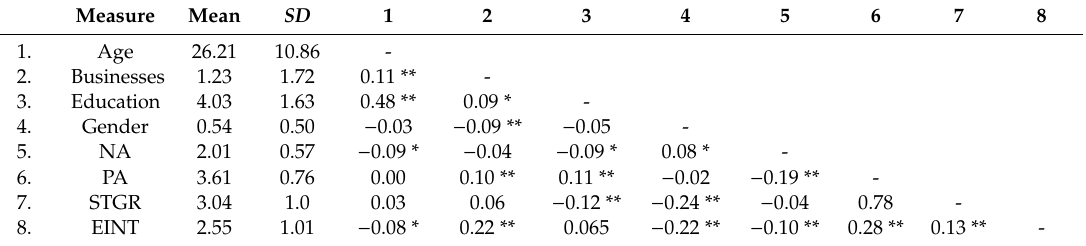
Table 1. Correlations of independent, dependent and demographic